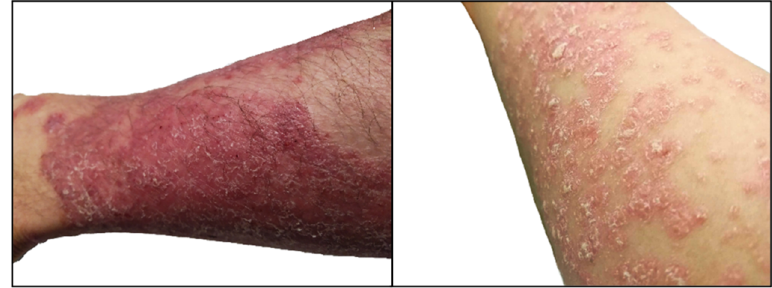
Figure 1. Clinical manifestations of plaque psoriasis on the hand from two different patients.